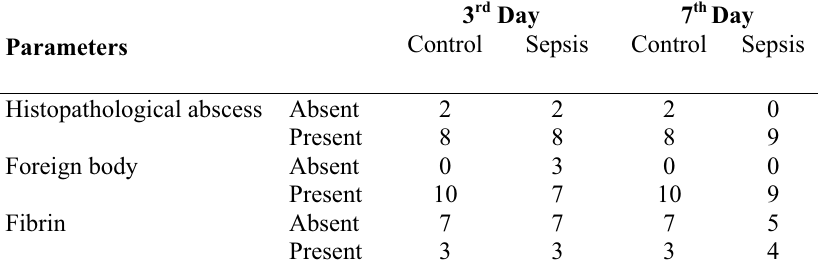
TABLE 4 - Number of animals by histopathological parameters divided in which group Parameters